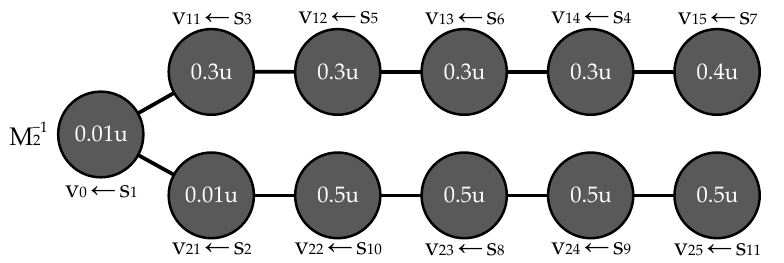
Figure 3. An example of a placement that equalizes the intermediate values of the integral risk obtained while moving away from the perimeter.